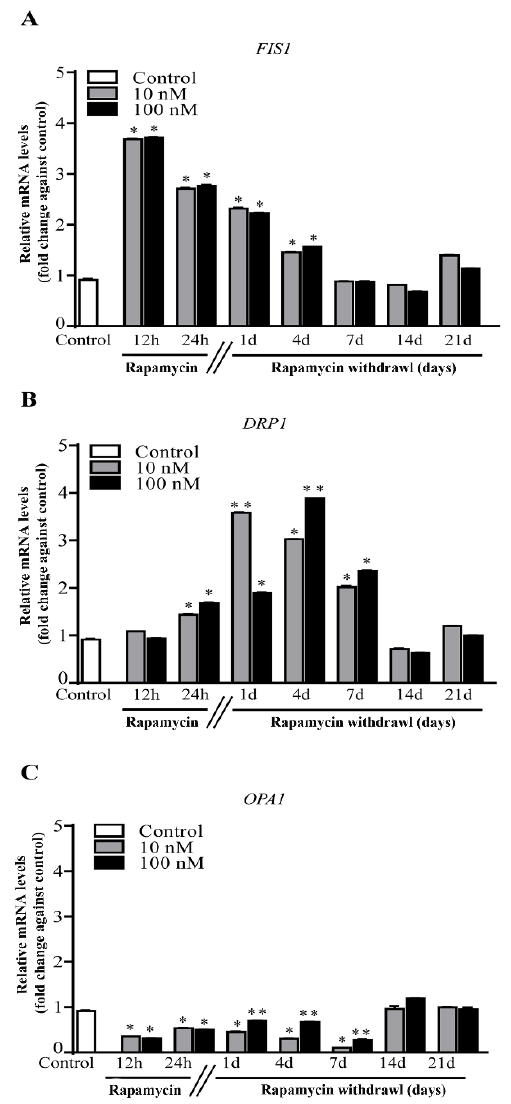
Figure 3. Effects of rapamycin on fission and fusion genes. RT-PCR for ( A ) FIS1 , ( B ) DRP1 , ( C ) OPA1 . The fission-related genes FIS1 and DRP1 were both increased by rapamycin, with an earlier increase concerning FIS1 , which reached back control levels at 7 days. DRP1 increased later reaching back control levels at 14 days. The fusion antigen OPA1 decreased following both a low and high dose of rapamycin and ruse back to control levels at 14 days. Counts represent the mean ± SD. * p ≤ 0.05 compared with control. ** p ≤ 0.05 compared with control and 10 nM rapamycin.